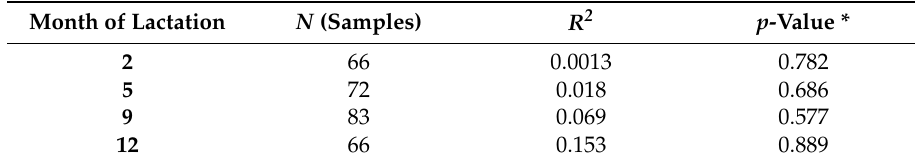
Figure 5. After accounting for the volume of milk consumed by the infant during the session, no differences in pre ‐ and post ‐ feed ( a ) whole and ( b ) skim human milk (HM) leptin values were detected in the study population.